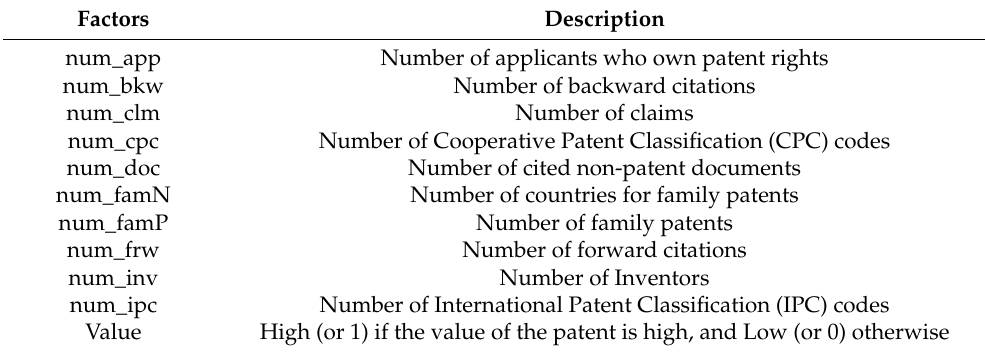
Table 2. Variables used in the proposed model.